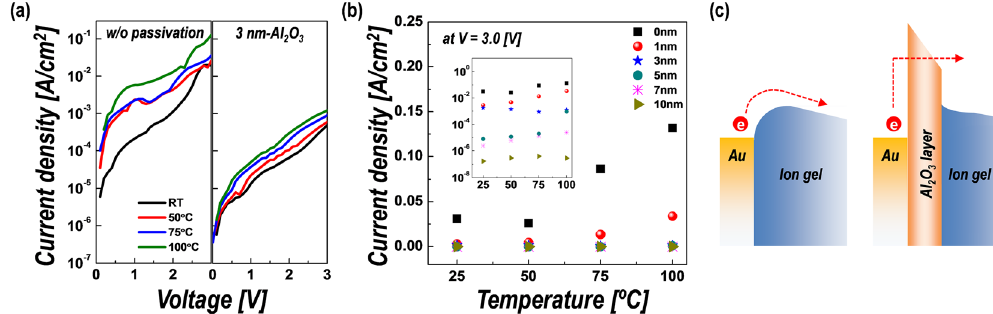
Figure 2. ( a ) J–V characteristics of ion gel film without passivation and with 3-nm-thick Al 2 O 3 passivation layer, measured from room temperature to 100 °C. ( b ) Temperature-dependent current density of hybrid structure with various thicknesses of Al 2 O 3 passivation layer, measured at 3 V bias. Inset: log-scale plot. ( c ) Schematics of current mechanism at metal–ion gel and metal–Al 2 O 3 –ion gel